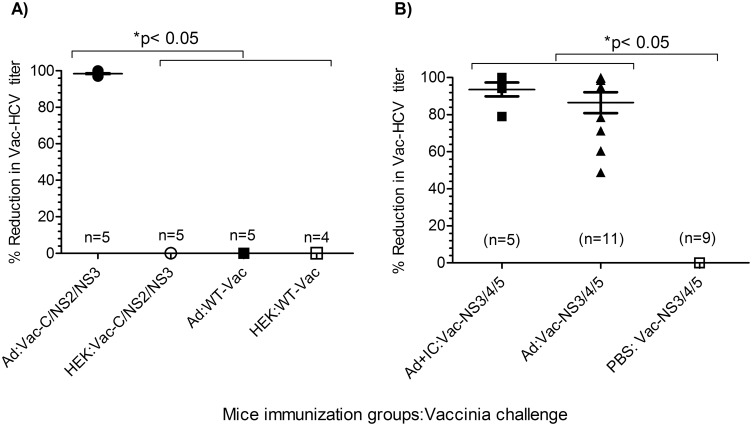
Immunization of mice with Ad vector leads to reduced titer of Vaccinia-HCV chimeric virus.Mice immunized twice intramuscularly with Ad vector (with or without poly I:C), PBS, or HEK cell lysate, were challenged 8 days after the second immunization with wild-type Vaccinia (WT-Vac) or chimeric Vaccinia-HCV. Ovaries were harvested 5 days after challenge and viral loads in each mouse were determined by plaque-forming assay using TK-1 cells. (A) Challenge with HCV core-NS2-NS3 (Vac-C/NS2/NS3) or wild type vaccinia (WT-Vac). (B) Challenge with Vaccinia-HCV NS3-NS4-NS5 (Vac-NS3/4/5). Data are presented as mean ± standard deviation of % reduction in viral titer compared to corresponding unimmunized control group, and statistical comparison was done by two-tailed t-test (p<0.05 was considered significant).